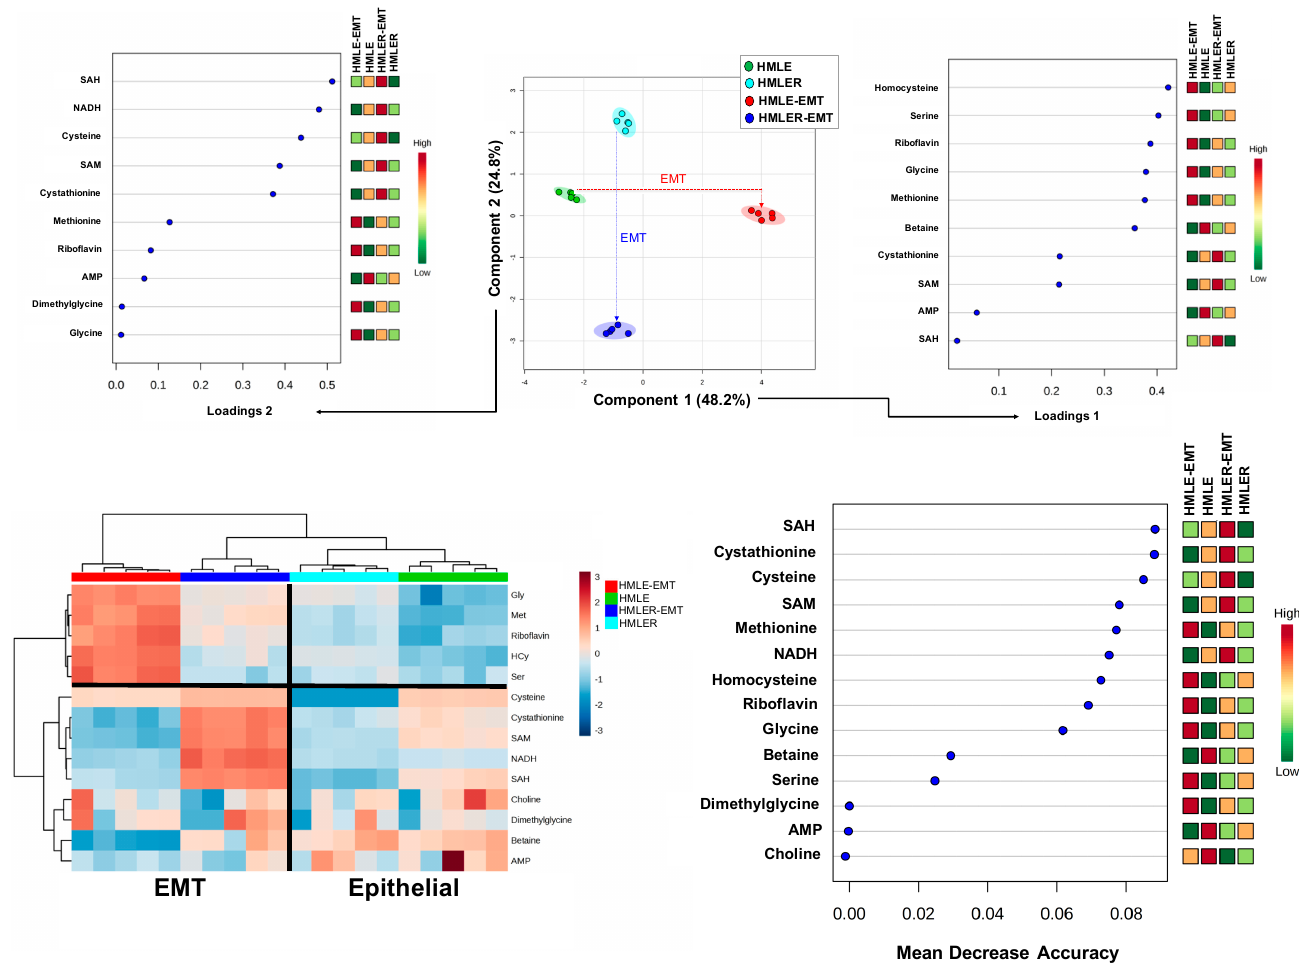
Figure 6. Homocysteine–methionine 1C metabolism fingerprints of non-tumorigenic and tumorigenic EMT (II). Top panels: PLS-DA showing four clusters and loading plots based on targeted homocysteine–methionine 1C metabolite profile data derived from HMLE/HMLE-EMT and HMLER/HMLER-EMT cells. Bottom panels: Heatmap visualization, hierarchical analyses, and random forest analysis of the homocysteine–methionine 1C metabolome of HMLE/HMLE-EMT and HMLER/HMLER-EMT cells. Rows: metabolites; columns: samples; color key indicates metabolite expression value (blue: lowest; red: highest). The list of the first 15 homocysteine–methionine 1C metabolites highlighted by their mean decrease accuracy value is presented for each cell model. Mean decrease accuracy is the measure of the performance of the model without each metabolite. A higher value indicates the importance of such metabolite in predicting each cell line group; removal of that metabolite causes the models to lose accuracy in prediction.